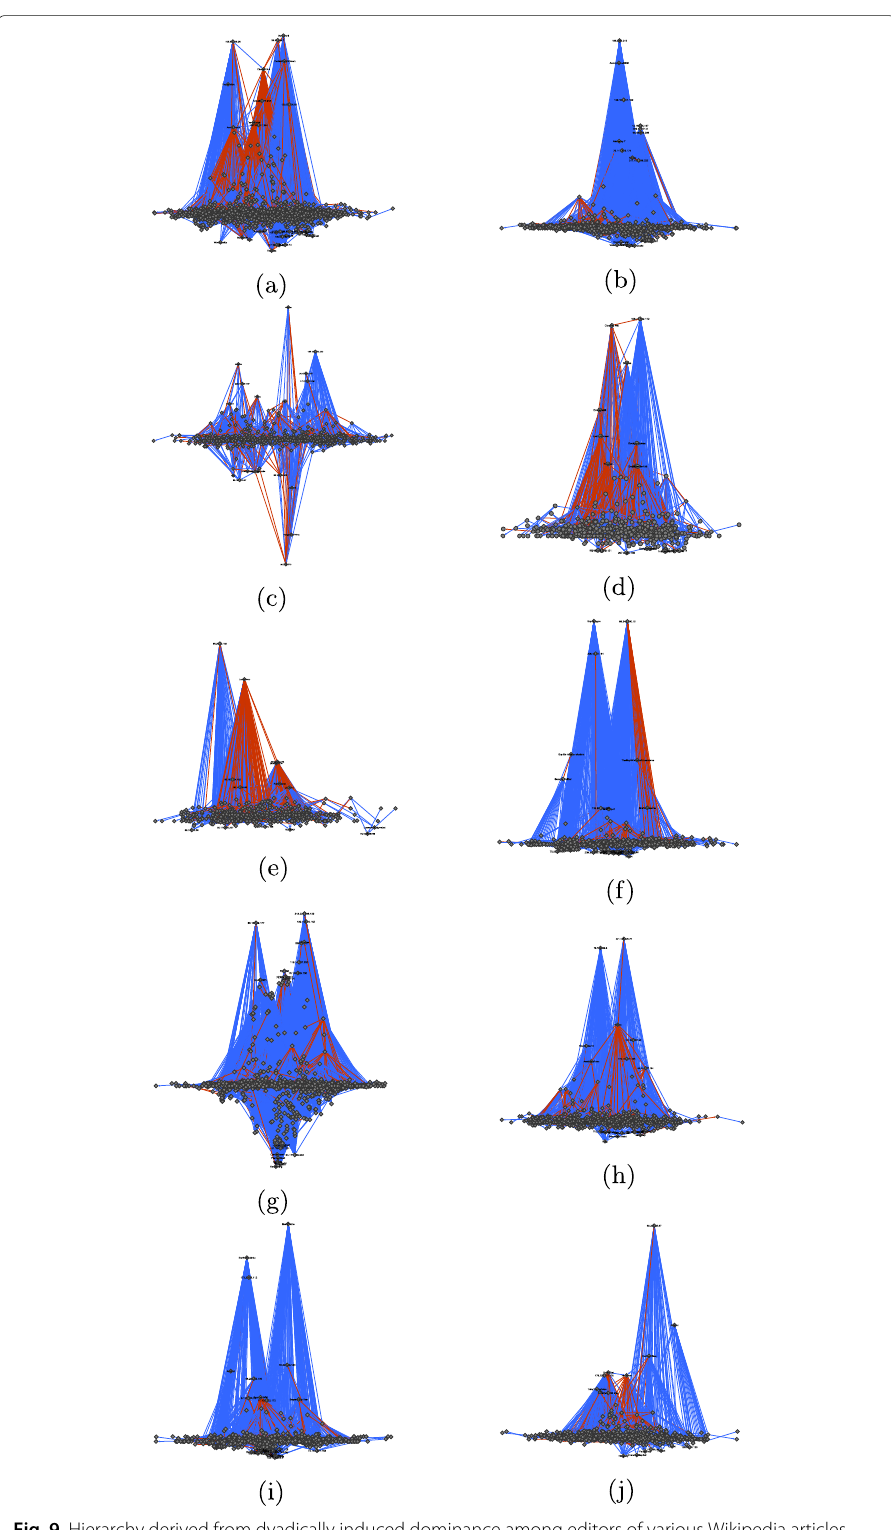
Fig. 9 Hierarchy derived from dyadically induced dominance among editors of various Wikipedia articles. The y -coordinate of node A is proportional to the value hierarchy . dyadic ( A ) . Dominance edges pointing in the wrong direction (i.e., from lower to higher) are coloredred . a Balika Vadhu. b Ganymede (moon). c Greed. d Jay Park. e List of Hollyoaks locations. f Mothra. g Pea. h Shiv Sena. i Swimsuit. j The Third